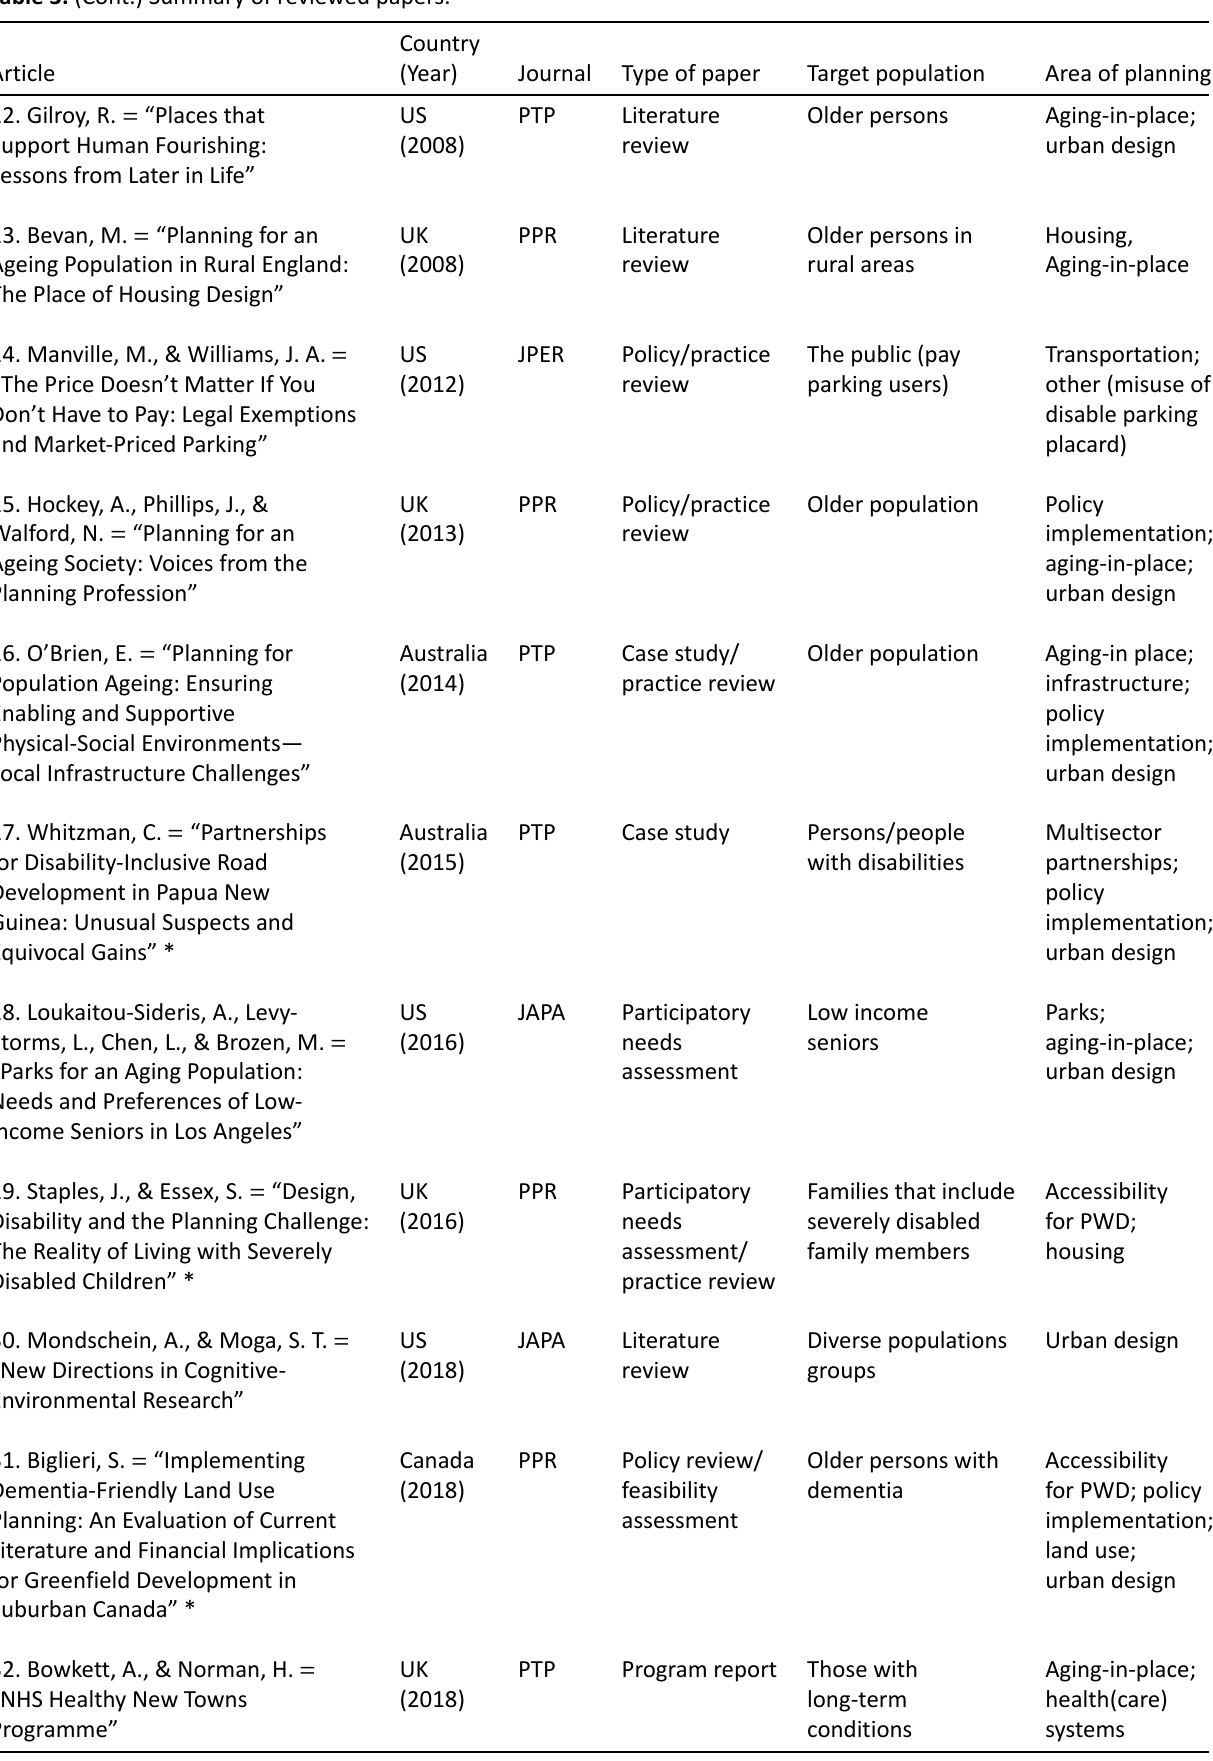
Table 3. (Cont.) Summary of reviewed